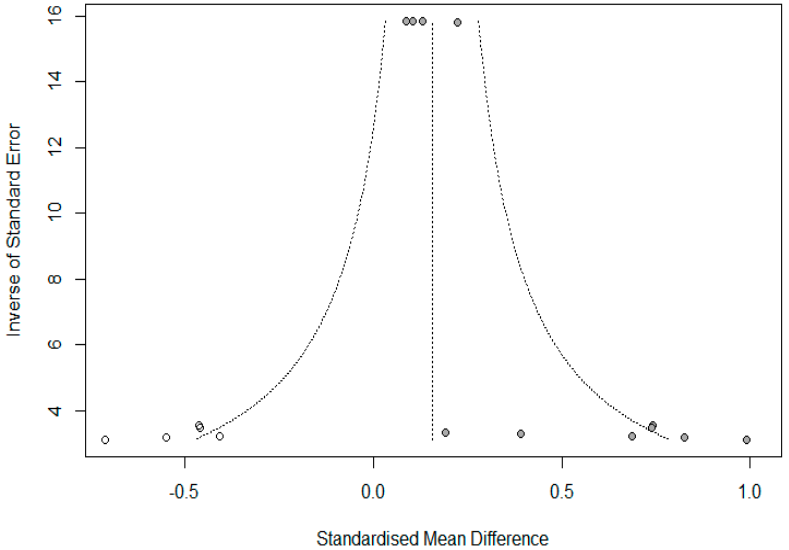
Figure 3. A funnel plot to assess potential publication bias. Measures of e ff ect size (standardized mean di ff erences) are represented on the x -axis and for study precision (the inverse of standard error) on the y -axis. The gray and white circles represent observed data (11 comparisons) and added data (5 studies), respectively.